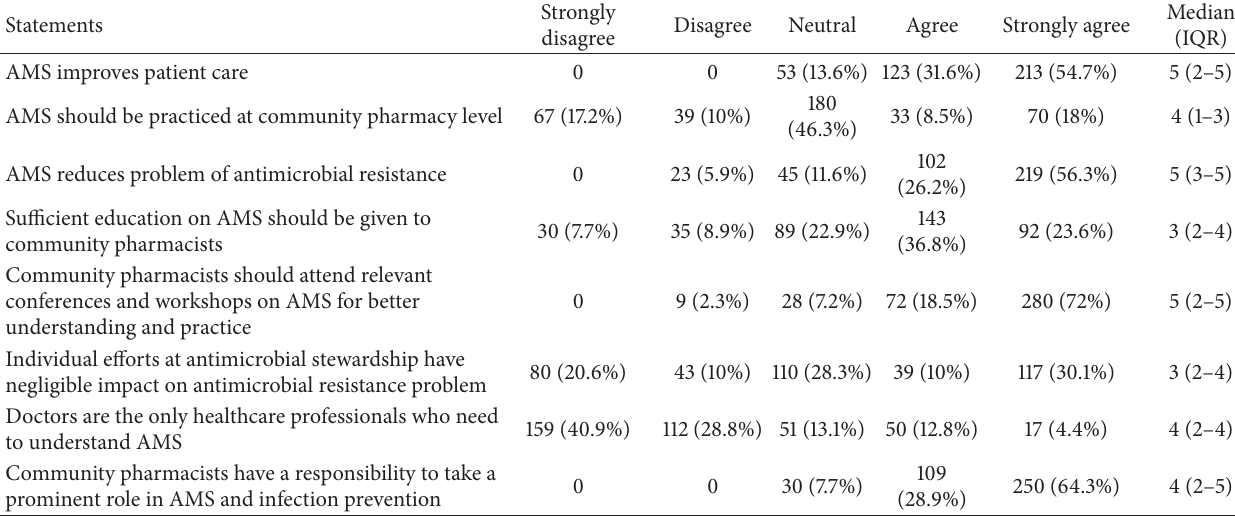
Table 2: Community pharmacists’ perception towards AMS ( 𝑁 = 389 ).